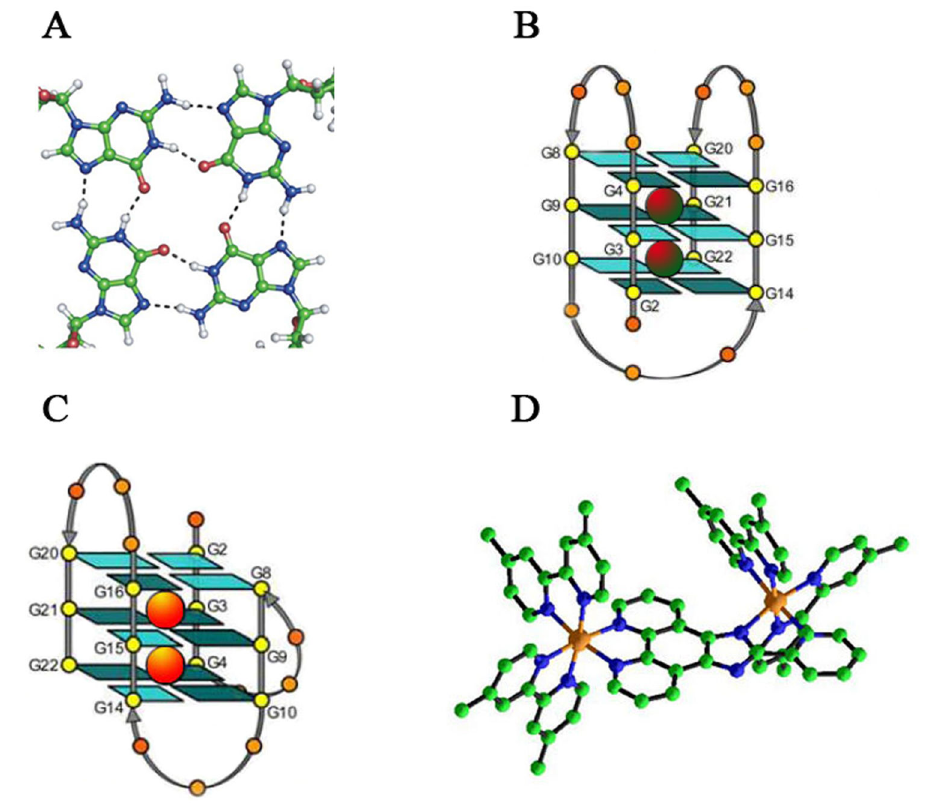
Figure 1. DNA and complex structures. A) structure of G-quartet with cyclic array of four guanines linked by Hoogsteen H- bonds, B) Anti-paralled G-quadruplex, C) Mixed-hybrid G-quadruplex, D)An ORTEP drawing of [(dmb) doi: